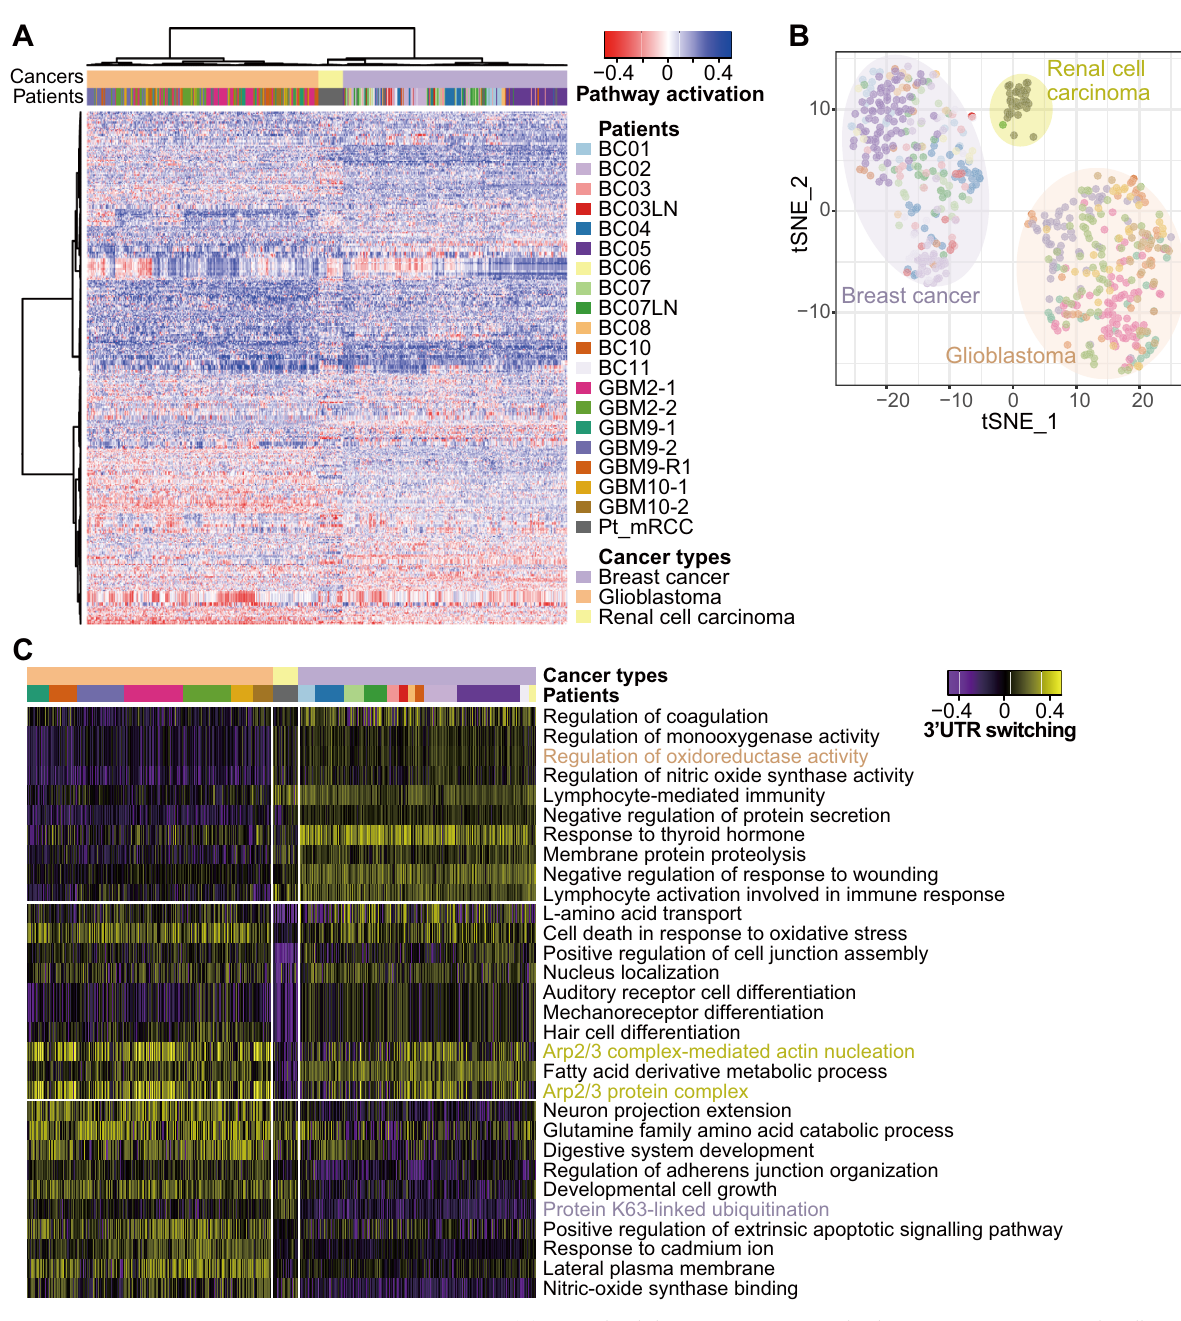
Fig 4. Heterogeneity of APA regulation among cancer types. (A) Hierarchical clustering using gene set-level APA estimates on 598 single-cells derived from 3 cancer types (280 tumor cells from 11 BC patients, 288 tumor cells from 3 GBM patients, and 30 tumor cells from 1 RCC patients). BC; Breast cancer, GBM; Glioblastoma, RCC; Renal cell carcinoma, T1,T2: Multiple regions in the brain, RLPS; Relapse. A total of 417 gene sets were used as variable components for hierarchical clustering and dimensional reduction (see Methods). (B) Unsupervised tSNE on the gene set-level APAs separating tumor cells along with cancer types. The dot colors represent patients which are the same as in Fig 4A. (C) APA map of top10 gene sets significantly (p < 0.01) switched in each cancer type. The colors for cancer types and patients are the same as in Fig 4A.